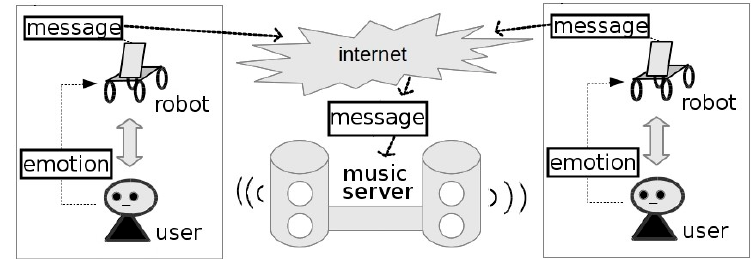
Figure 2. Robotic sonification system architecture. Each robot serves as a client. The interaction data between each robot and child are integrated in the sonification server.